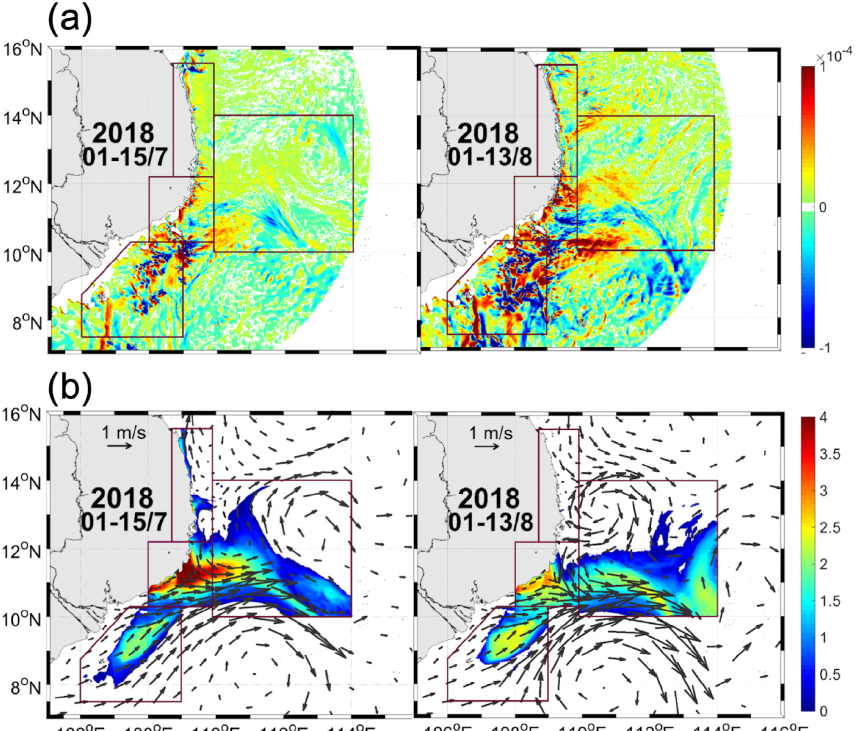
Figure 18. Vertical velocity (ms − 1 , first row) and daily upwelling index ( ◦ C, second row) and surface currents (ms − 1 ) averaged over the July (a, c) and August (b, d) periods of upwelling development in summer